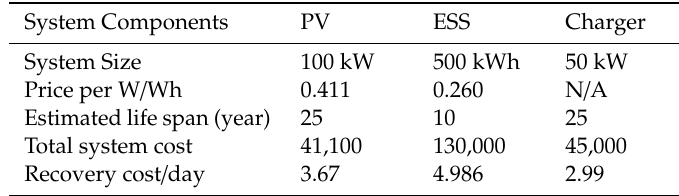
Table 1. Photovoltaic (PV), energy storage system (ESS), and charger total system and recovery costs (NZ$).